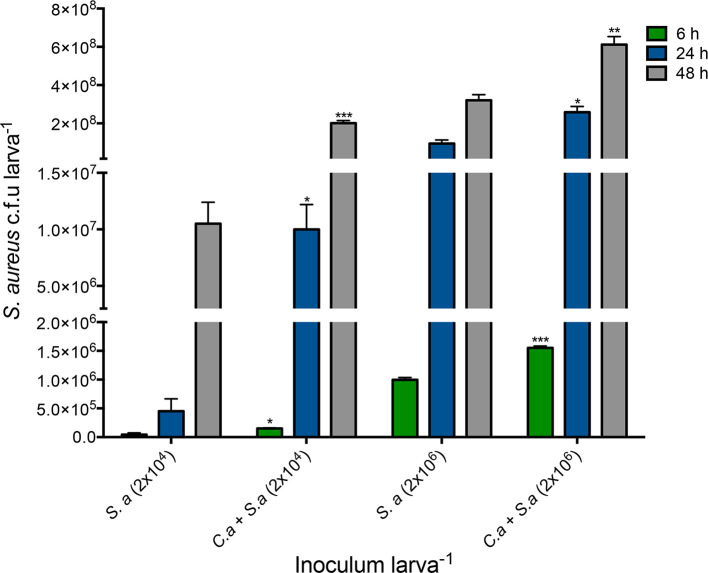


S. aureus
 c.f.u. larva−1 obtained from G. mellonella larvae infected with 
S. aureus
 cells (2×106 and 2×106 larva−1) or co-infected larvae over 48 h at 37 °C. Co-infection with C. albicans and 
S. aureus
 (C. a+S. a) results in an increase in bacterial load in larvae from 6 to 48 h as determined by plating on nutrient agar plates. Statistical analysis was carried out by comparing co-infected larvae (C. a+S. a) to larvae infected solely with 
S. aureus
 (S. a) at their respective timepoints, (*, P<0.05; **, P<0.01). All values are the mean±se of three independent experiments.